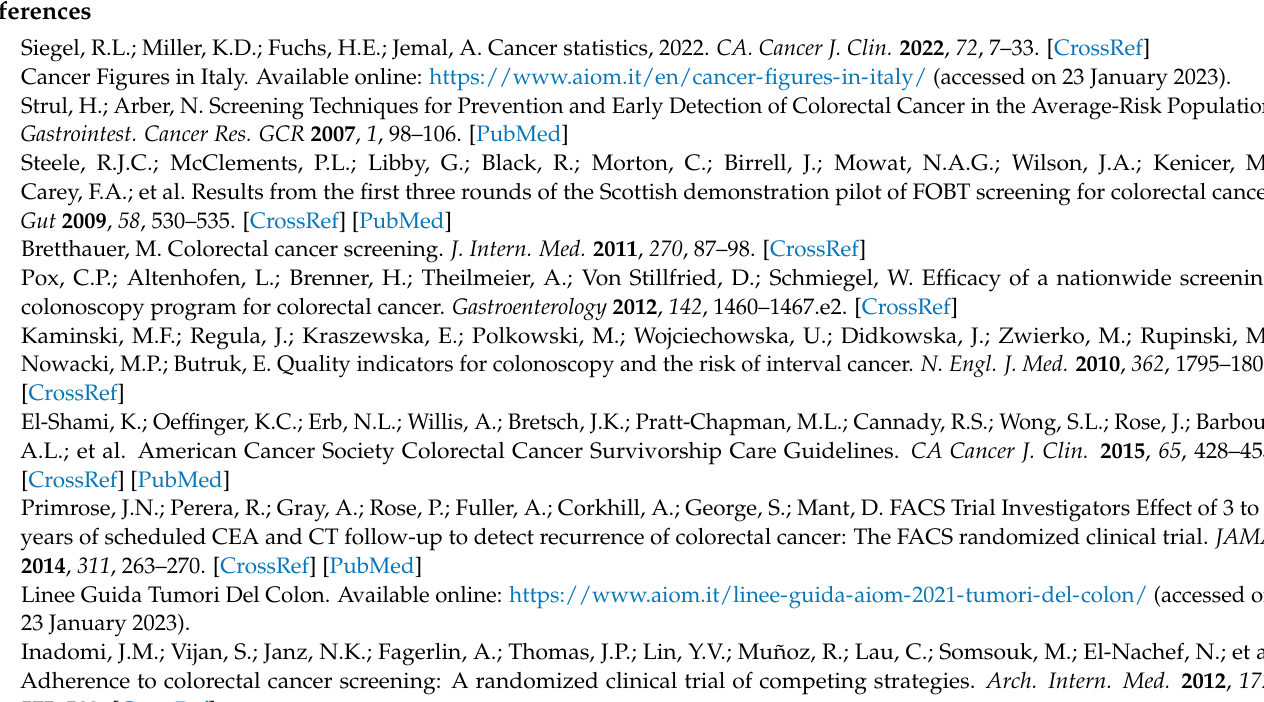
Figure S2: The SCENT B2; Figure S3: Internal details of SCENT B2; Figure S4: Sensor output